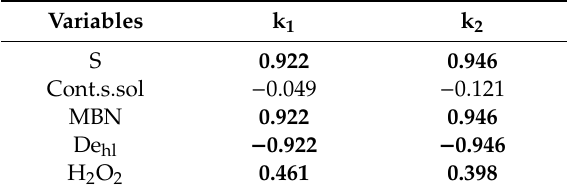
Table 8. Values of correlation coe ffi cients between the characteristics of activated carbons and the kinetic parameters (pseudo-first / second order) for phenol